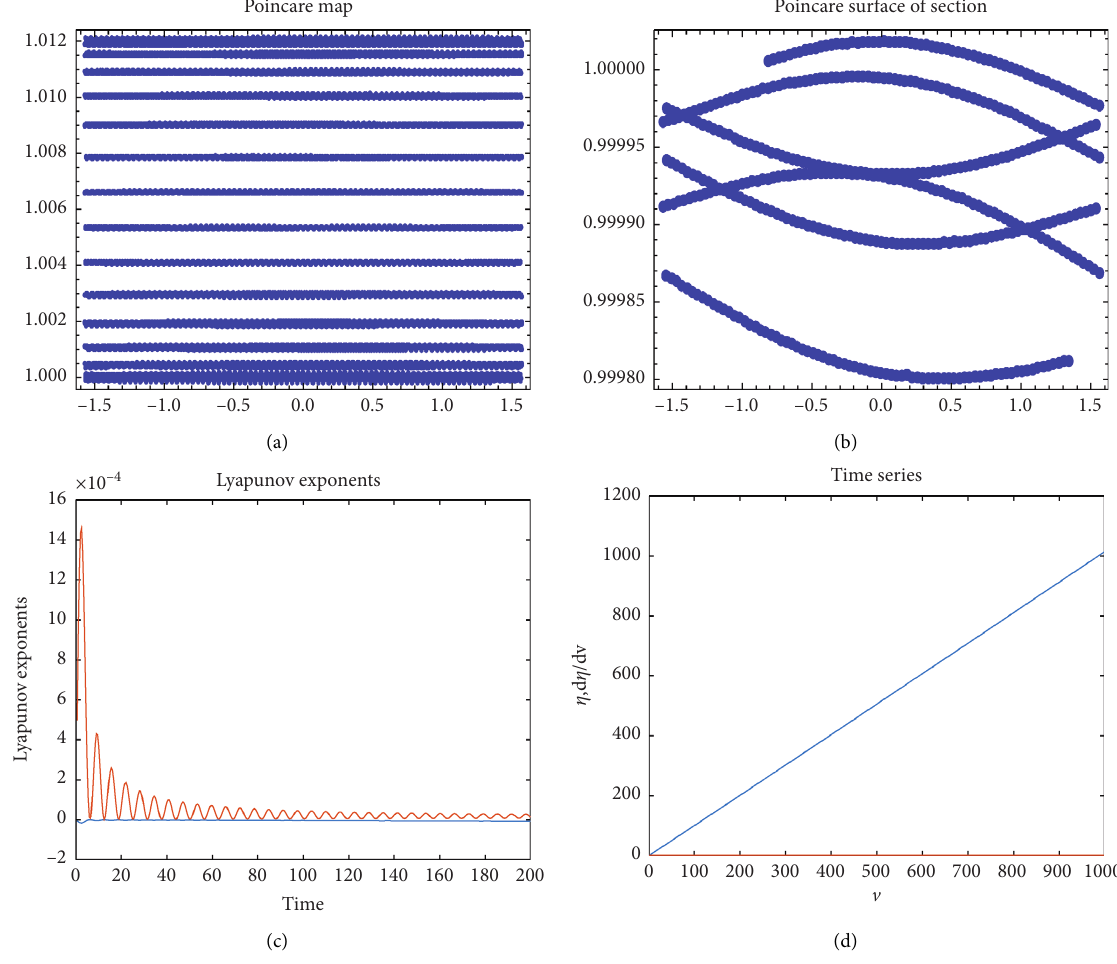
Figure 7: For n � 0 . 005 , ε � 0 . 000000000000000000005 , A � 200 . 1022 , and e � 0 . 001. (a) Poincare map, (b) Poincare surface of section, (c) Lyapunov exponent, and (d) time E ∗